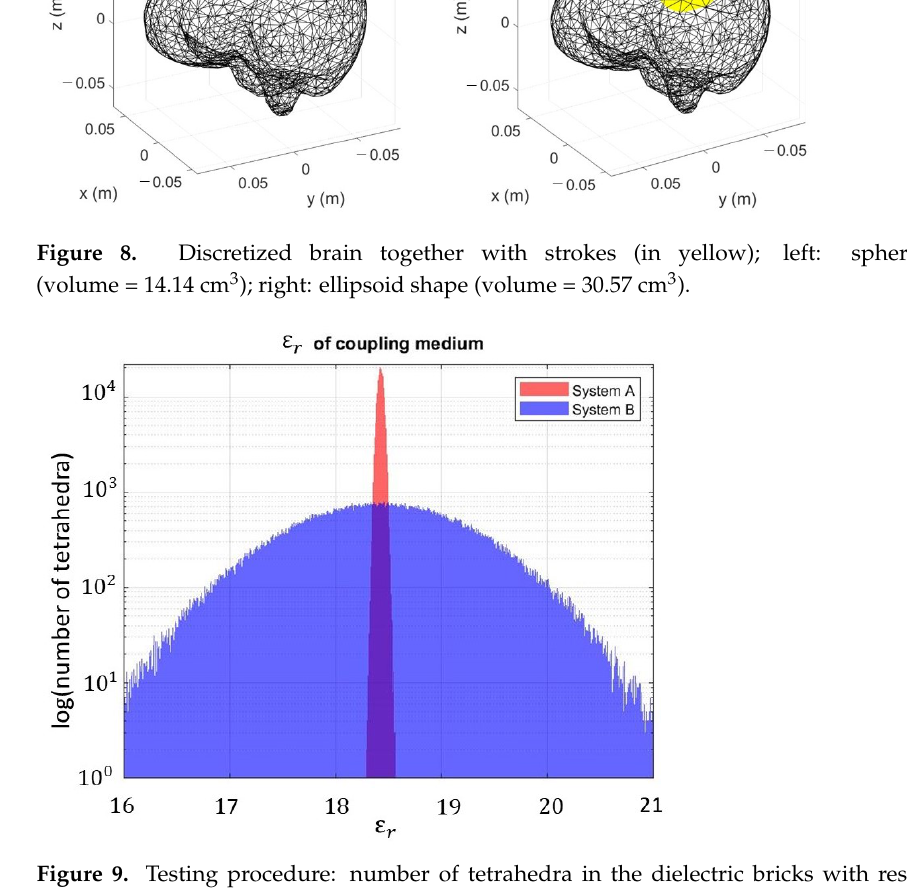
Figure 9. Testing procedure: number of tetrahedra in the dielectric bricks with respect to the associated (cid:101) r ; red: standard deviation equal to 0.03; blue: standard deviation equal to